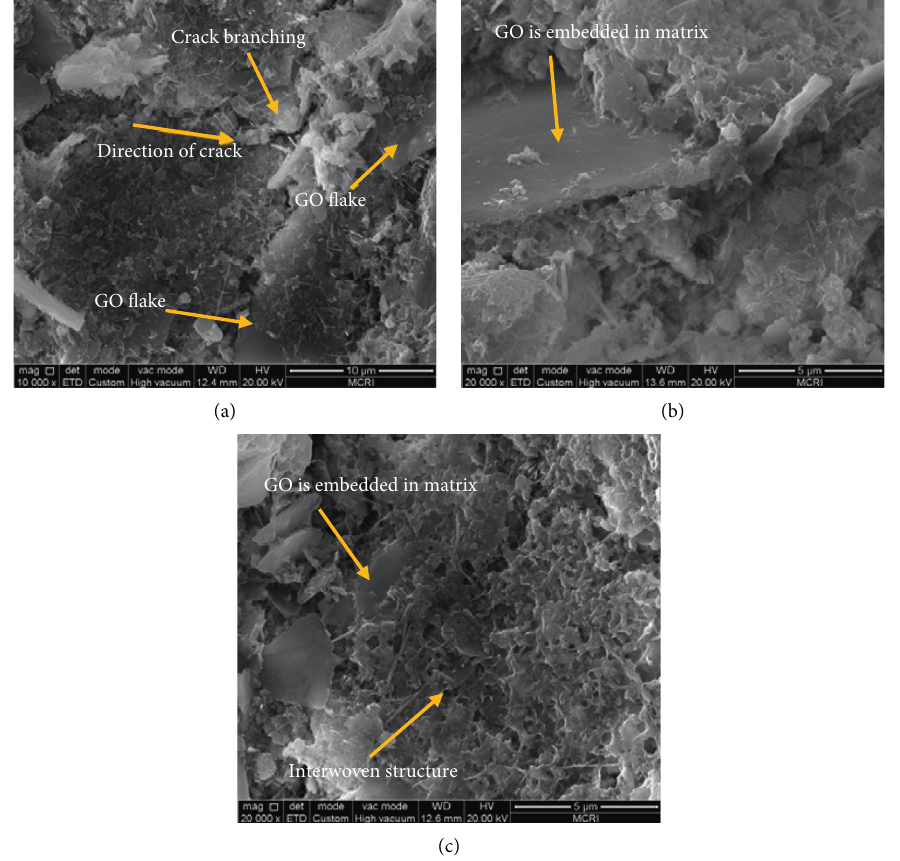
Figure 13: Characteristic toughening mechanism of GO reinforced cemented